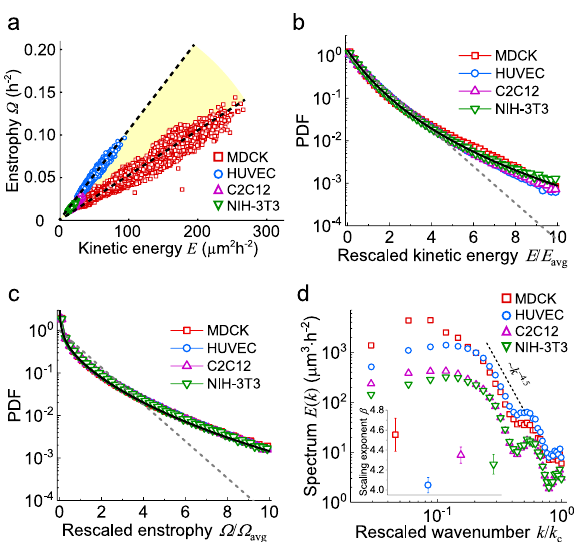
Fig. 4 Energetic statistics of mesoscale cell turbulence in Madin Darby canine kidney cell monolayers adhering to various substrates of different stiffness. a The enstrophy scales linearly with the kinetic energy over time. Different symbols refer to different substrates, including polyacrylamide (PA) gels substrate (red squares), polydimethylsiloxane (PDMS) substrate (blue circles), plastic substrate (upward-pointing triangles), and glass substrate (downward-pointing triangles). The numbers refer to the Young ’ s moduli of these substrates. Data were collected from some independent fi eld of views (FOVs): n = 10 for PA gel substrate, n = 9 for PDMS substrate, n = 8 for plastic substrate, and n = 8 for glass substrate. The dashed lines represent linear fi ttings to Ω ¼ E = ξ 2 with the characteristic a length scales ξ a ; plastic (cid:3) 44 : 1 μ m for plastic substrate and ξ a ; PA gel (cid:3) 30 : 7 μ m for PA gel substrate. The yellow sector represents the data set area ( E , Ω ) of Ω ¼ E = ξ 2 with ξ a bounded by ξ a ; plastic and ξ a ; PA gel . a b , c Representative probability density functions (PDFs) of b the rescaled kinetic energy and c the rescaled enstrophy. Values are rescaled by their average. The gray dashed curves represent the Maxwell – Boltzmann distribution, while the black solid curves refer to the fi ttings to q -Gaussian distributions (Eq. (2) for b and Eq. (4) for c ) with the Tsallis index q ¼ 1 : 2. d Representative energy spectra E ( k ). k c represents the wavenumber at the scale of one cell. Inset: the scaling exponent β as a function of the Young ’ s modulus of substrates (symbols refer to different substrates). Error bars: mean ± SD. Data were collected from n independent FOVs and m independent samples: n = 10 and m = 4 for PA gel substrate, n = 9 and m = 4 for PDMS substrate, n = 8 and m = 4 for plastic substrate, and n = 8 and m = 4 for glass